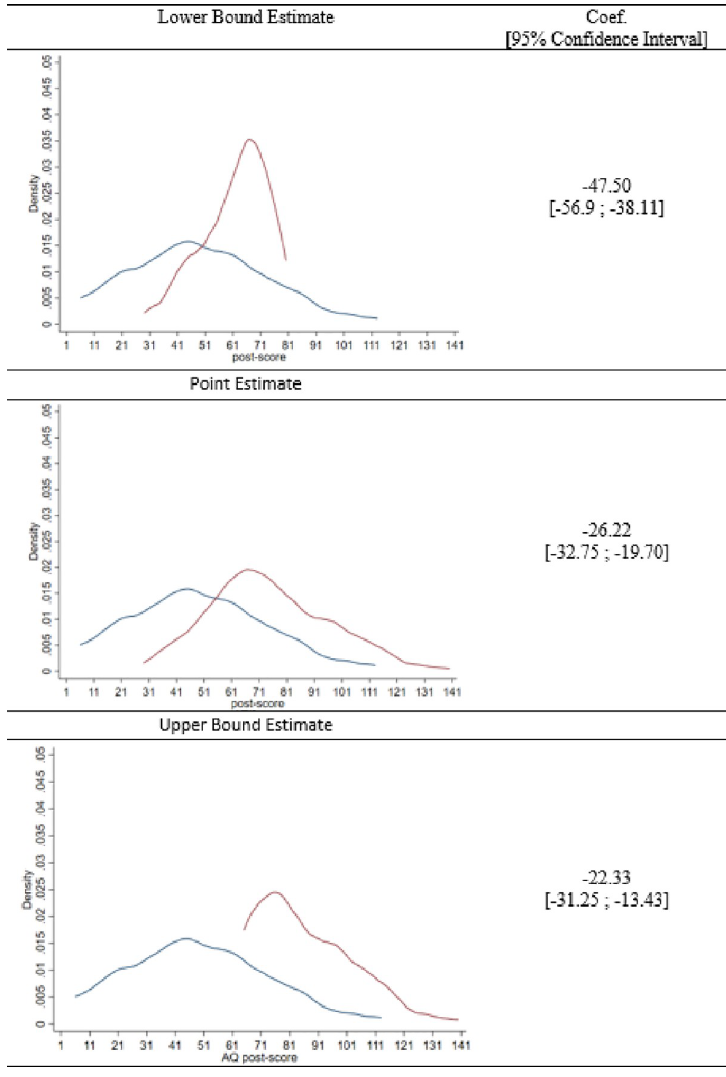
Fig 1. Lee bounds trimming